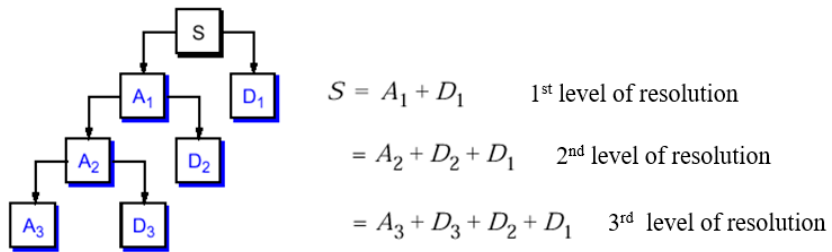
Figure 7. Decomposition of an S signal on three levels. A and D represent respectively the approxi- mation and the detail of the signal.